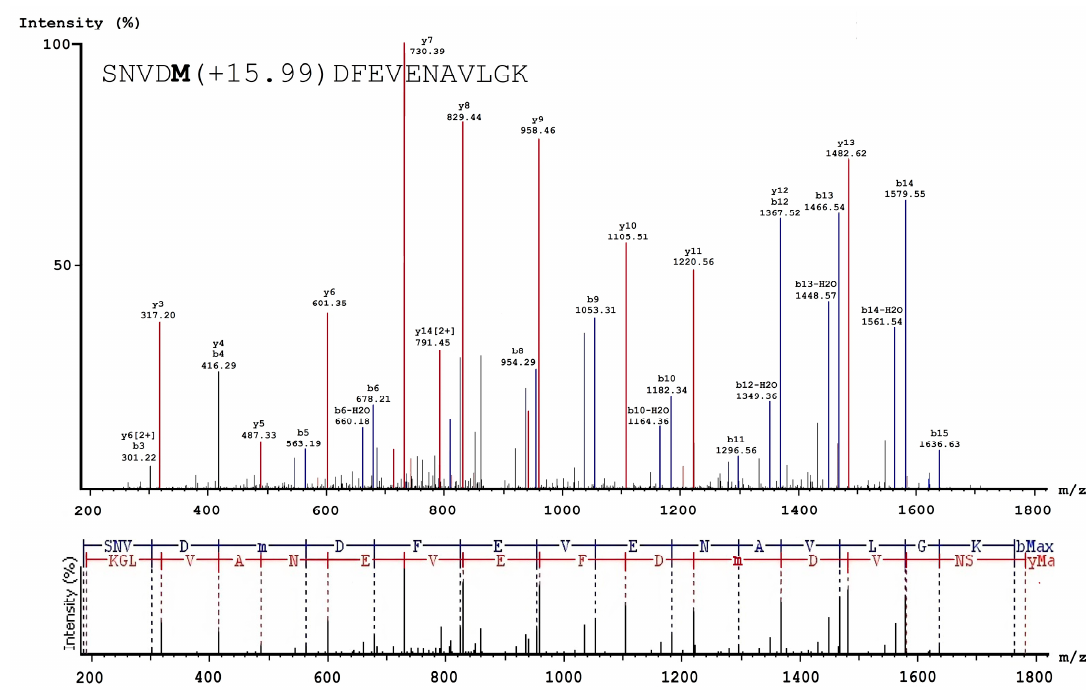
Figure 4. Representative example of the de novo sequencing validating quantification and identification of hypochlorite-modified peptides. The MS / MS spectrum of the doubly charged ion at m / z 891.92 from the 150 µ M oxFXIII sample identified as SNVDM( + 15.99)DFEVENAVLGK with an oxidatively modified methionine residue. The y1 ion observed at m / z 147.11 was assigned to the C-terminal residue K and used to identify the remaining amino acid residues by calculating the mass di ff erence of adjacent y-ions. The tryptic peptide contained the oxidation site corresponding to Met383 in the FXIII-B subunit. The oxidized Met M ( + 15.99) corresponded to a mass shift of 165.2 Da (149.21 Da for methionine and 15.99 Da due to the addition of one oxygen atom).